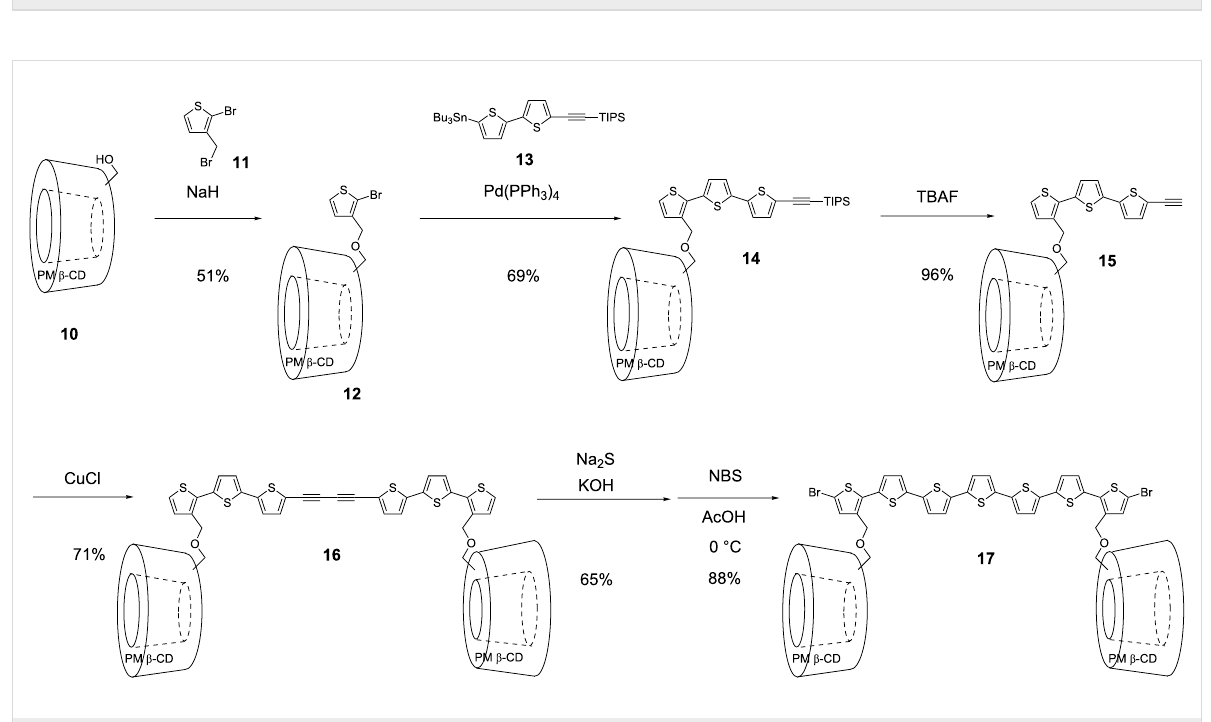
Scheme 2: Selective synthesis of fixed [3]rotaxane by Suzuki cross-coupling reaction.